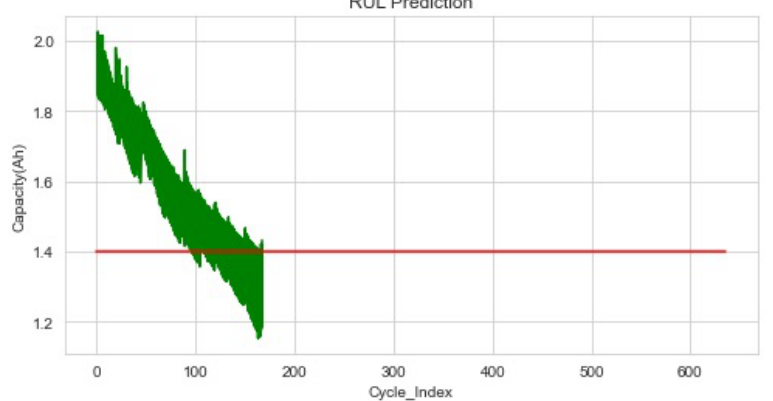
Figure 8. Results of the battery dataset’s prediction.